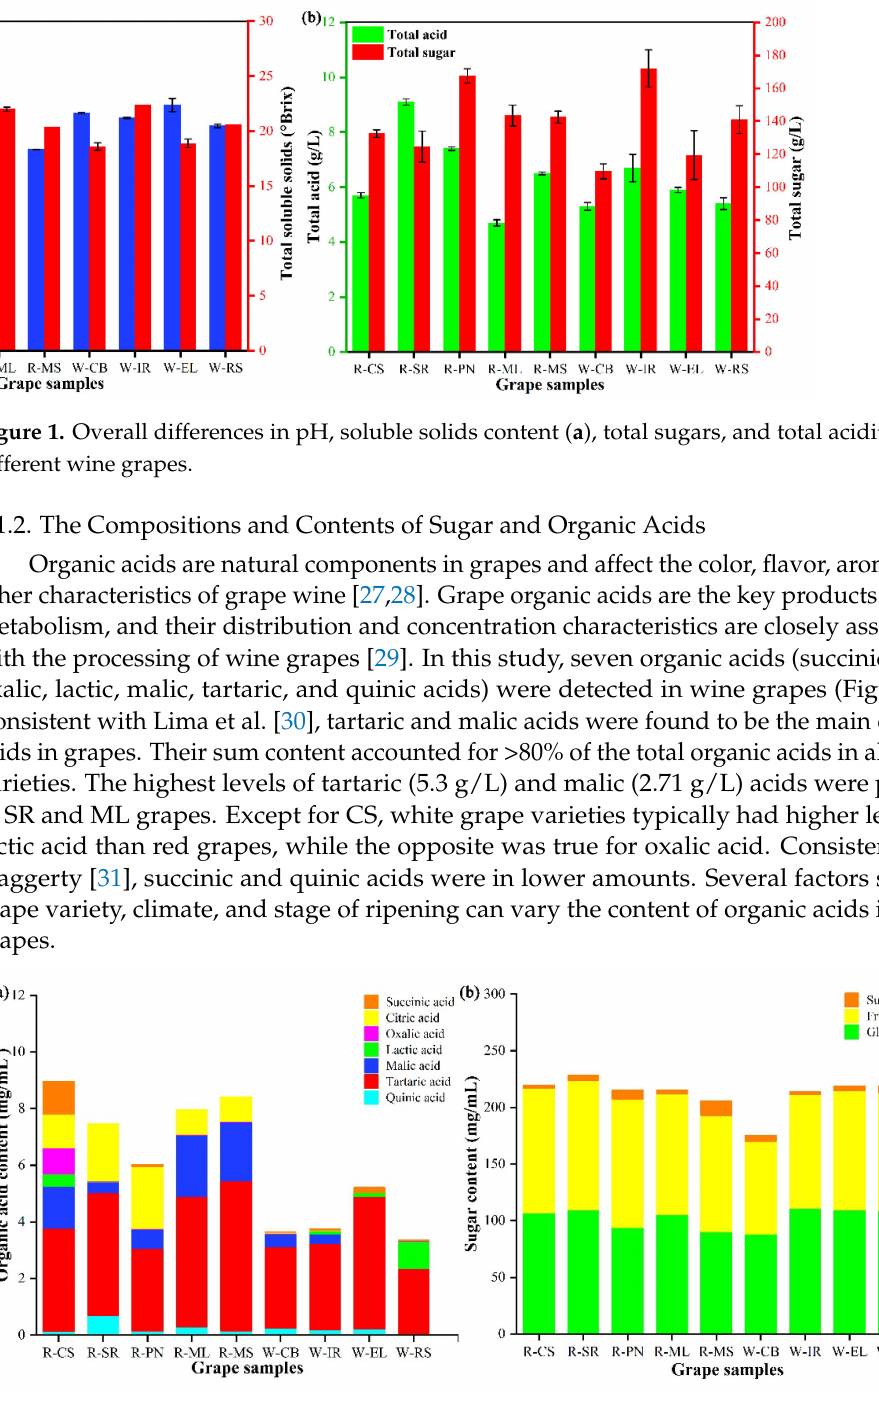
Figure 2. Differences in the organic acids ( a ) and soluble sugars ( b ) in different wine grape